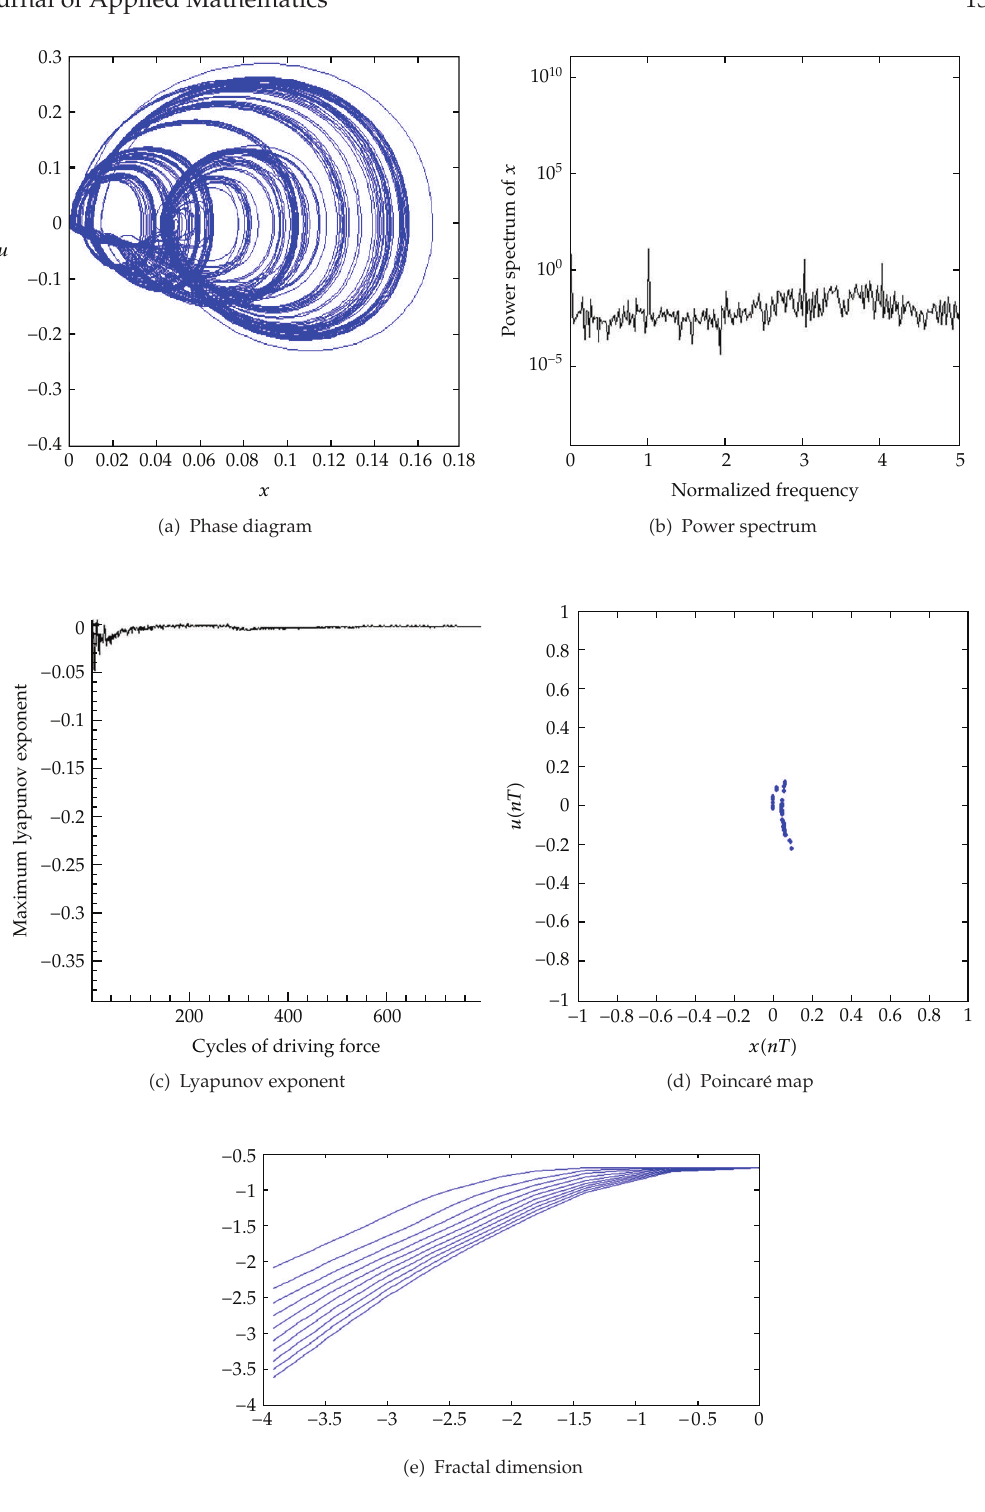
Figure 7: Simulation results obtained for rotor-bearing system with s (cid:8) 0 . 32 (cid:2) with rub-impact e ff ect (cid:3)